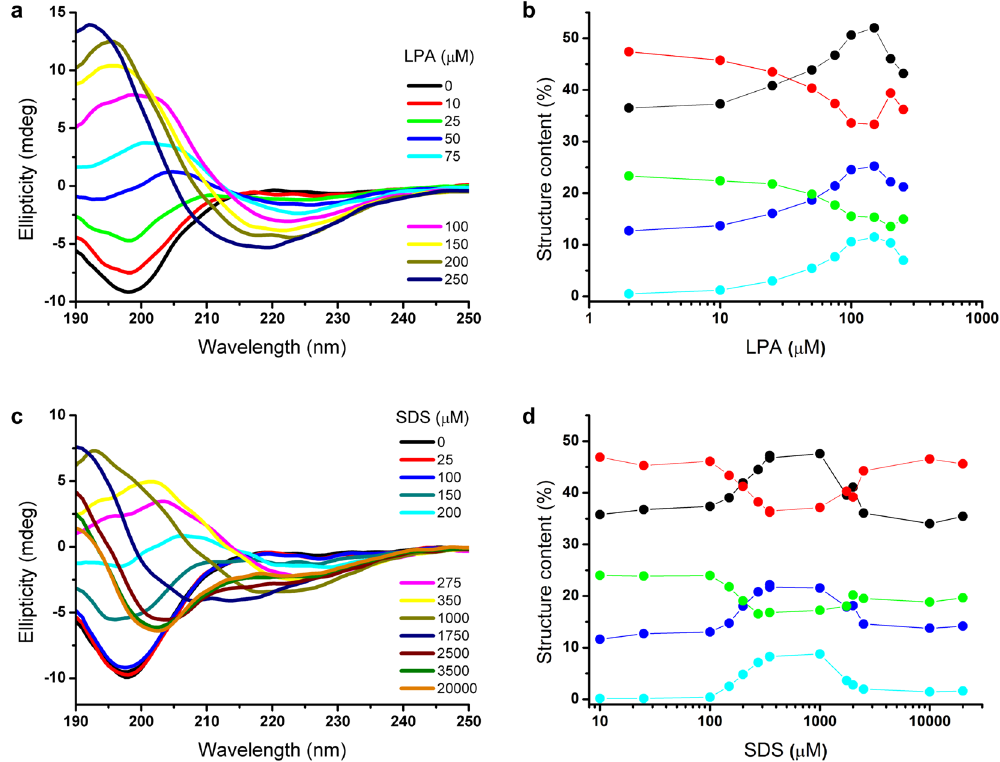
Figure 6. Structural changes of peptide GAP43IQ induced by LPA and SDS traced by CD spectroscopy. ( a – c ). Spectra of the peptide recorded in the absence and in the presence of the lipids. ( b – d ) Lipid concentration- dependent changes in peptide conformation highlighting elements with pronounced alterations upon interaction. Secondary structure elements are according to the classification of the analysis method used considering three types of antiparallel β -sheet with different twists (cyan, blue and green). The content of all the individual β -forms, the total estimated β -conformation (black), and the disordered fraction (red) changed in the same lipid concentration range. Note that structural changes in the presence of SDS and LPA follow similar trends but take place at different concentrations, for LPA at CMC and for SDS much below the